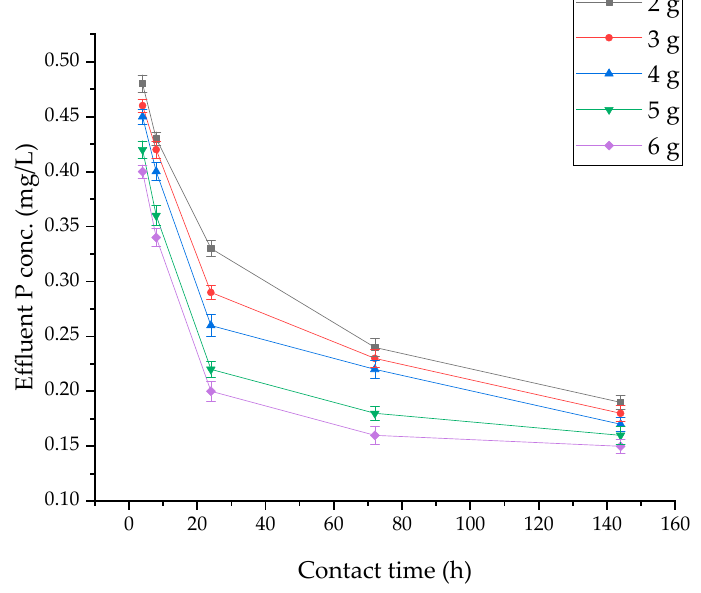
Figure 7. Effect of contact time on phosphorus removal efficiency.